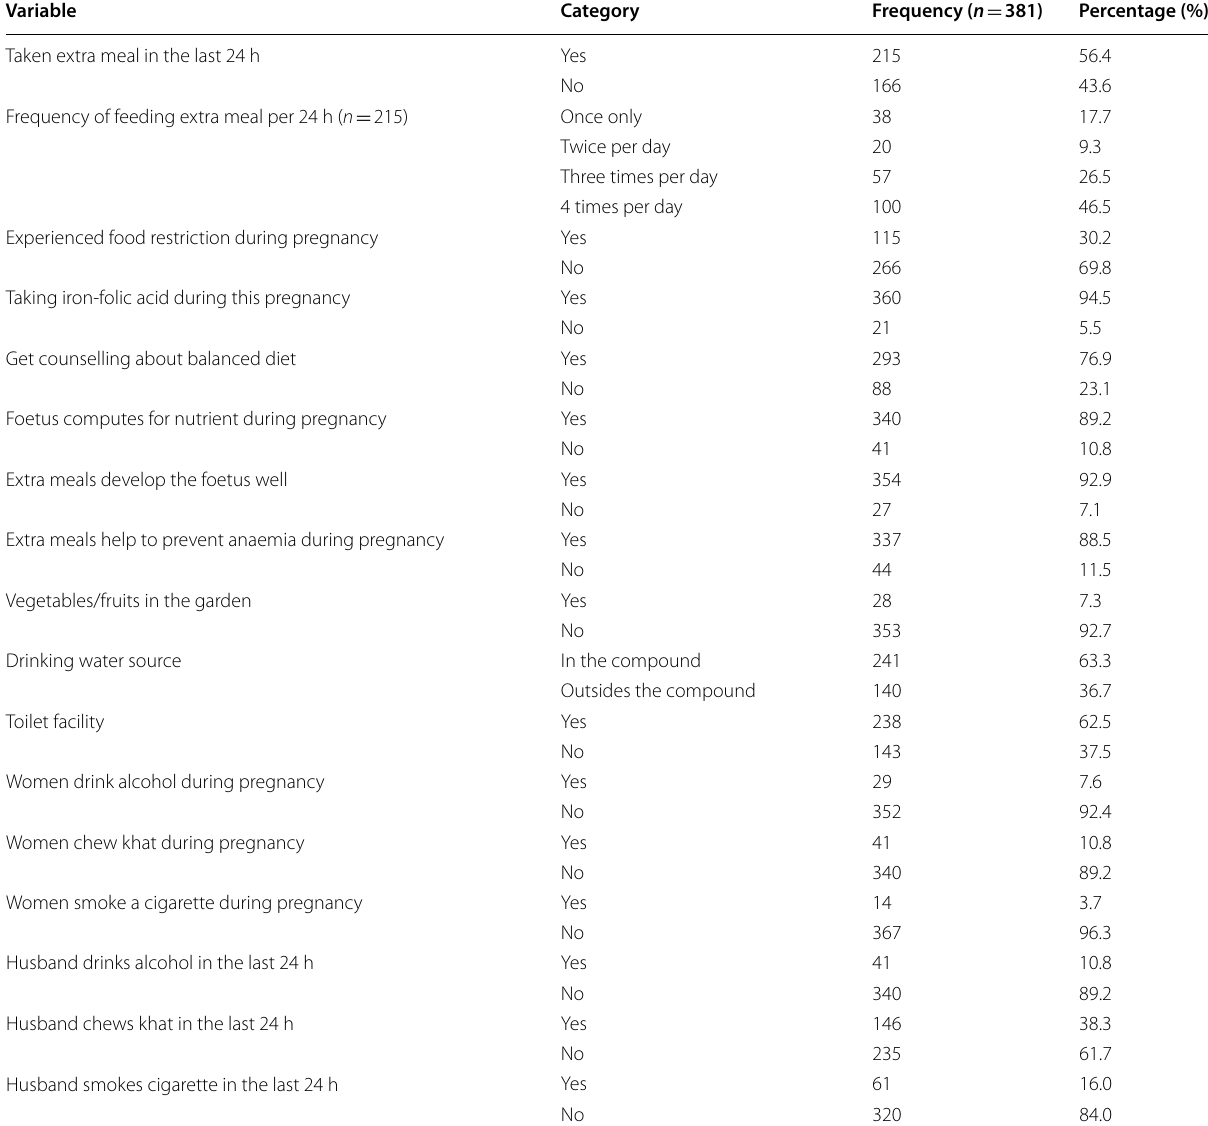
Table 3 Nutritional status, lifestyle, and behavioural characteristics of pregnant women in the Afar region, northeast Ethiopia